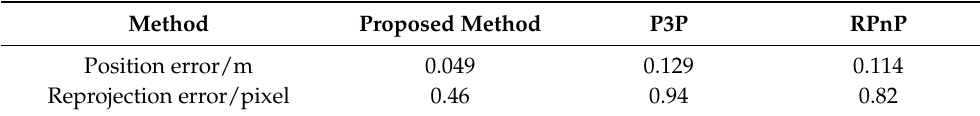
Table 3. The position error and reprojection error in the second